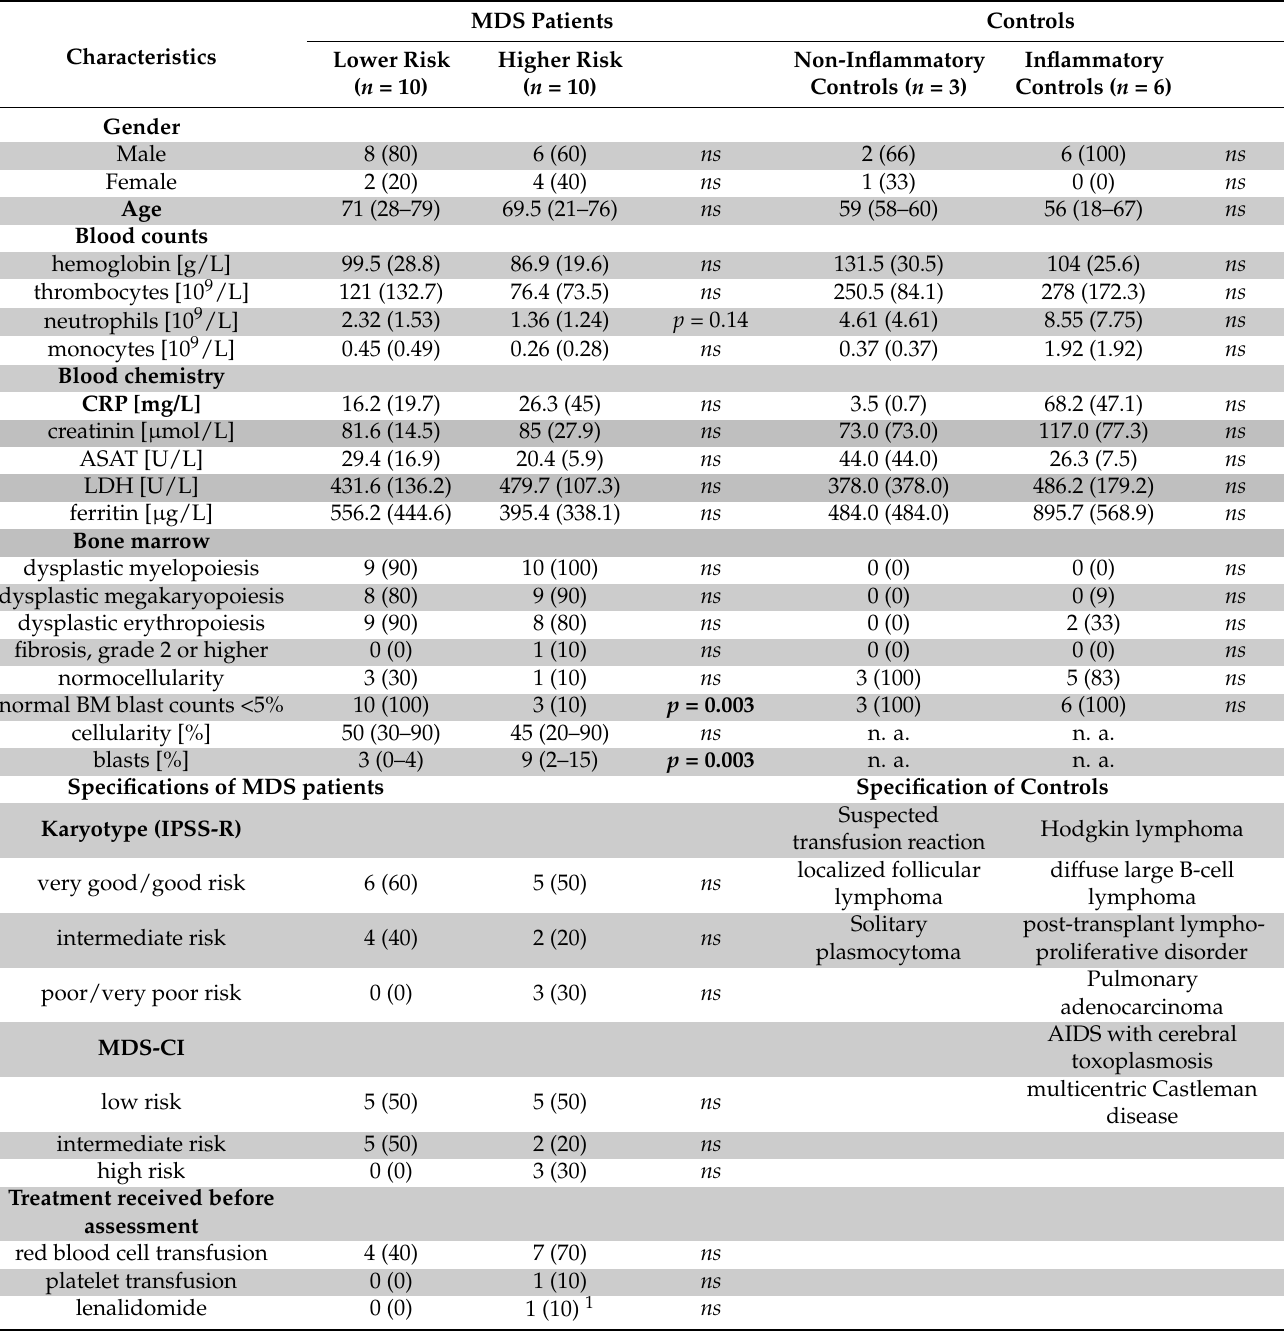
Table 1. Characteristics of MDS patients and